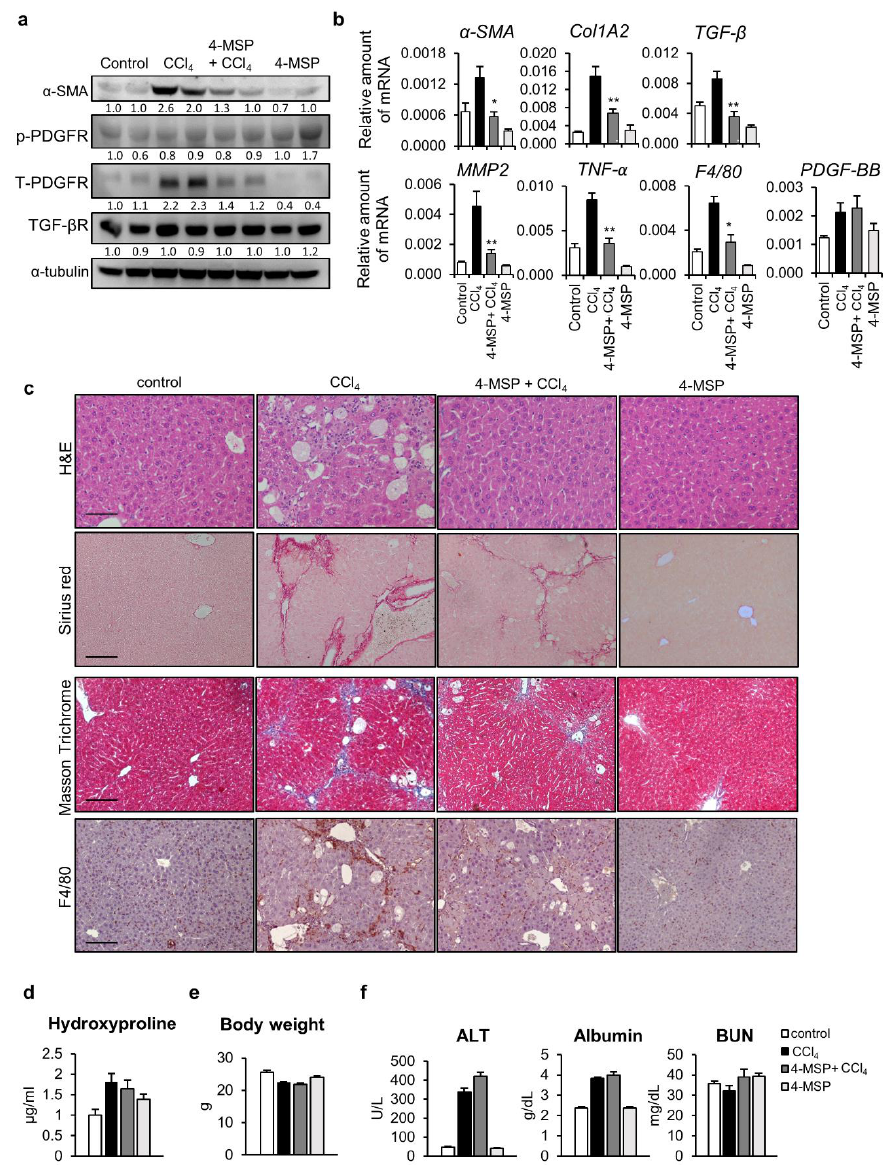
Figure 5. Mice treated with compound 4-MSP attenuate CCl 4 -induced liver damage and fibrosis. ( a ) Hepatic protein levels of α -SMA, T / P-PDGFR, TGF- β R, and α -tubulin from four groups were analyzed by western blot. ( b ) mRNA levels of α -SMA, col1A2, TGF- β , MMP2, TNF- α , and F4/80 relative to that of GAPDH (n = 6 per group) were measured by RT-PCR. Data are expressed as the mean ± SD. *: p < 0.05 vs. CCl 4 alone group; **: p < 0.01 vs. CCl 4 alone group. ( c ) Representative images of H&E, Sirius Red, Masson’s Trichrome stainings, and F4 / 80 immunohistochemical (IHC) staining of liver tissues from each treatment group. The black bar represents a length of 0.1 mm. ( d ) Liver hydroxyproline quantification was performed, according to the manufacturer’s instruction. ( e ) Mean body weight of individual mouse group at the endpoint of the experiment. ( f ) Serum samples were acquired at the endpoint of the experiment, and the BUN, albumin, and ALT values were